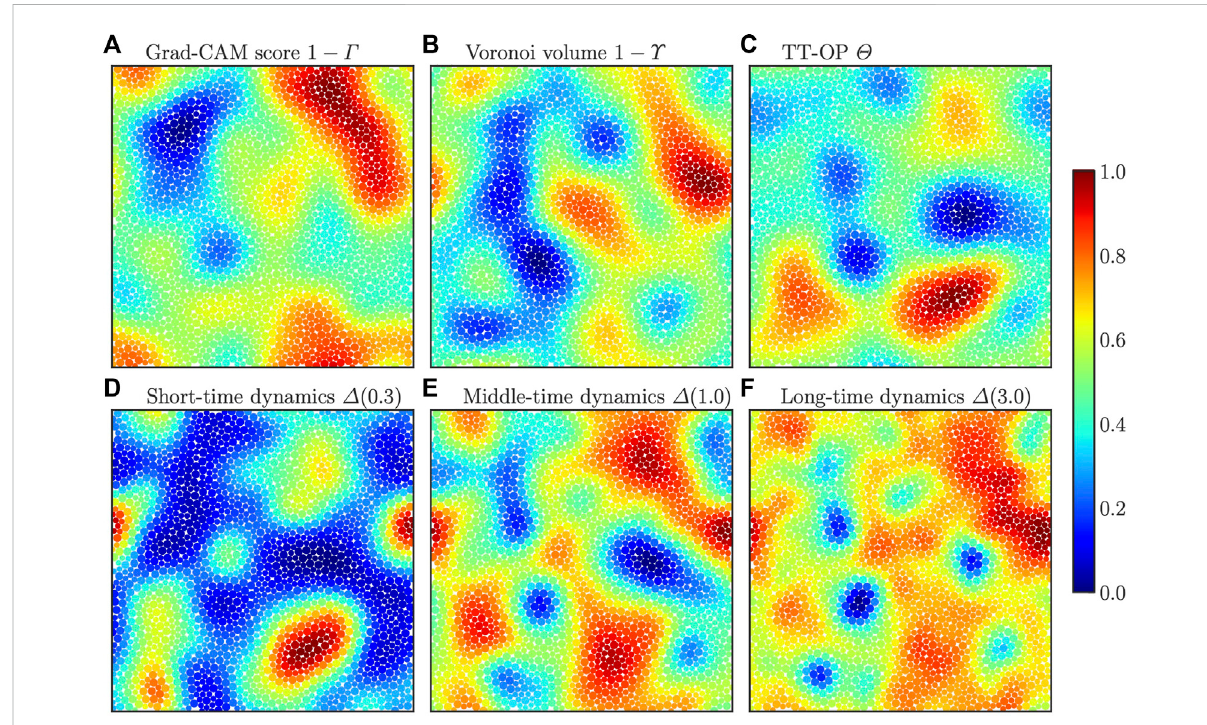
FIGURE 2 Visualizationofparticle-basedstructural indicatorsfor atypical glasscon fi gurationintheABM system. The meaningsof thepanels arebasically the same as those presented in Figure 1 ( (A) Grad-CAM score, (B) Voronoi volume, (C) TT-OP, (D – F) Dynamic propensity at different time scales), while 1 − ϒ and Θ are shown in panels (B) and (C) , rather than ϒ and 1 − Θ